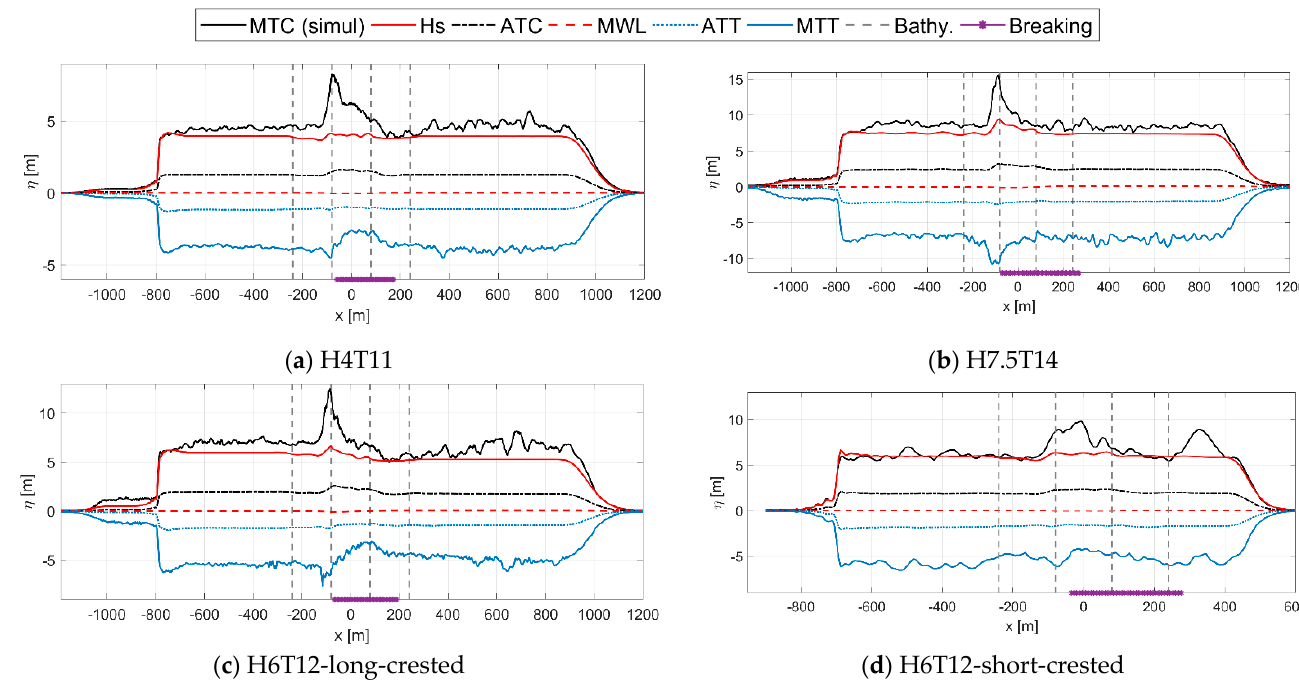
Figure 12. Wave-prints of the three breaking cases. In ( a ) H4T11 and in ( b ) H7.5T14 for 1D long-crested waves. For wave case H6T12, long-crested is shown in ( c ), and short-crested in ( d ).